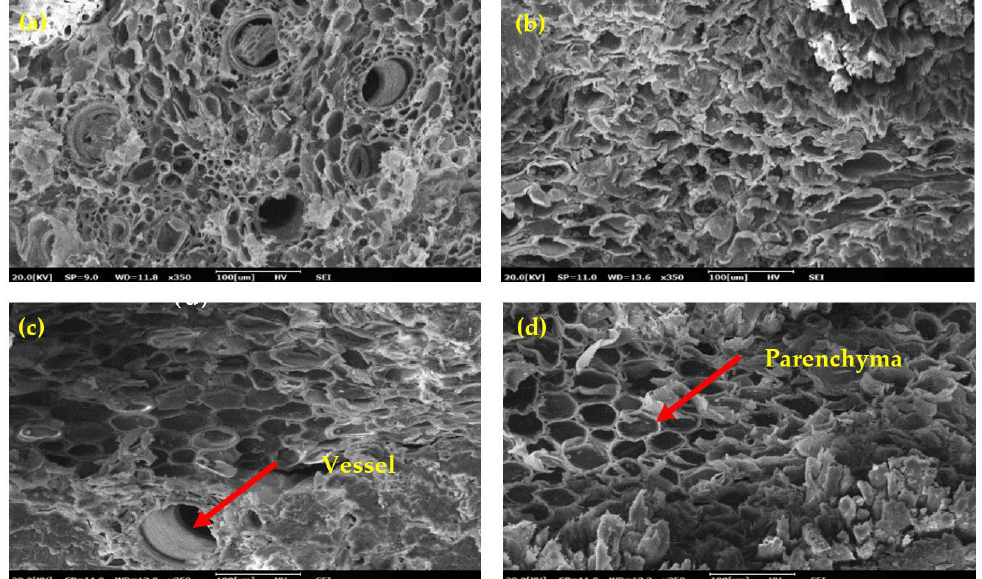
Figure 4. SEM for treated bamboo strips of ( a ) Dendrocalamus asper , ( b ) Bambusa vulgaris , ( c ) Gigan- tochloa scortechinii , and ( d ) Gigantochloa levis (350×).